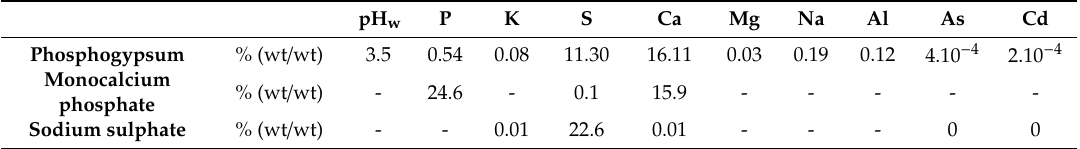
Table 9. Chemical composition of the fertilizers used in the experiment. pH w P K S